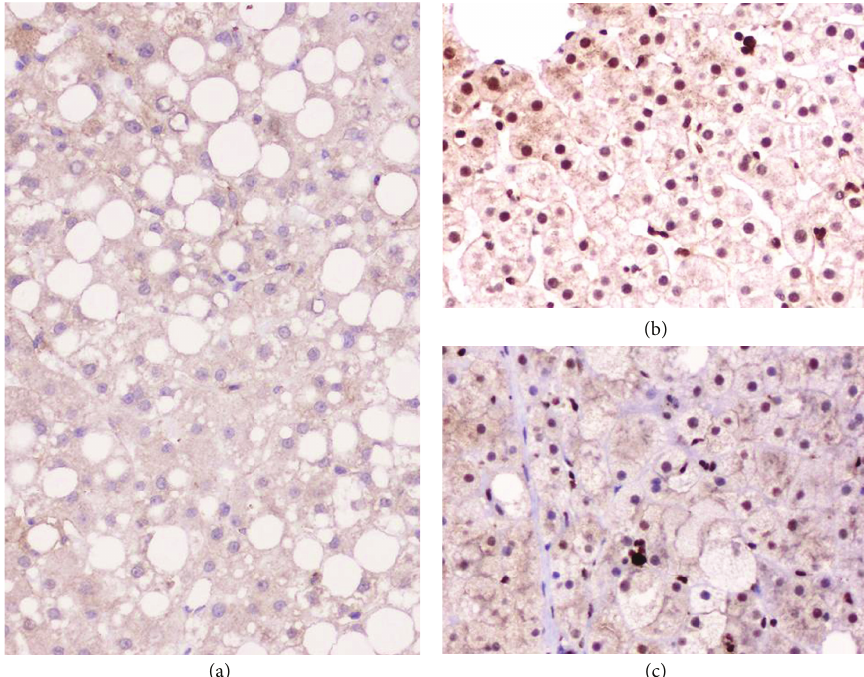
Figure 2: Immunohistochemical staining of liver biopsies with anti-ATM antibody. Absence of hepatocyte nuclear staining in the A-T patient (a). Nuclear immunostaining is observed in a normal liver (b) and in a liver biopsy specimen from an obese patient with nonalcoholic steatohepatitis (c) (immunoperoxidase, original magnification: ×